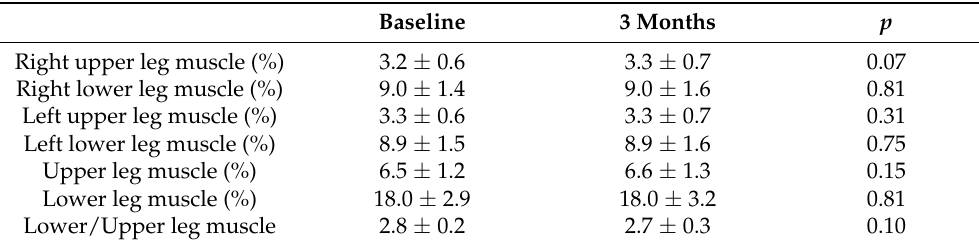
Table 3. Changes in upper and lower leg muscle after semaglutide